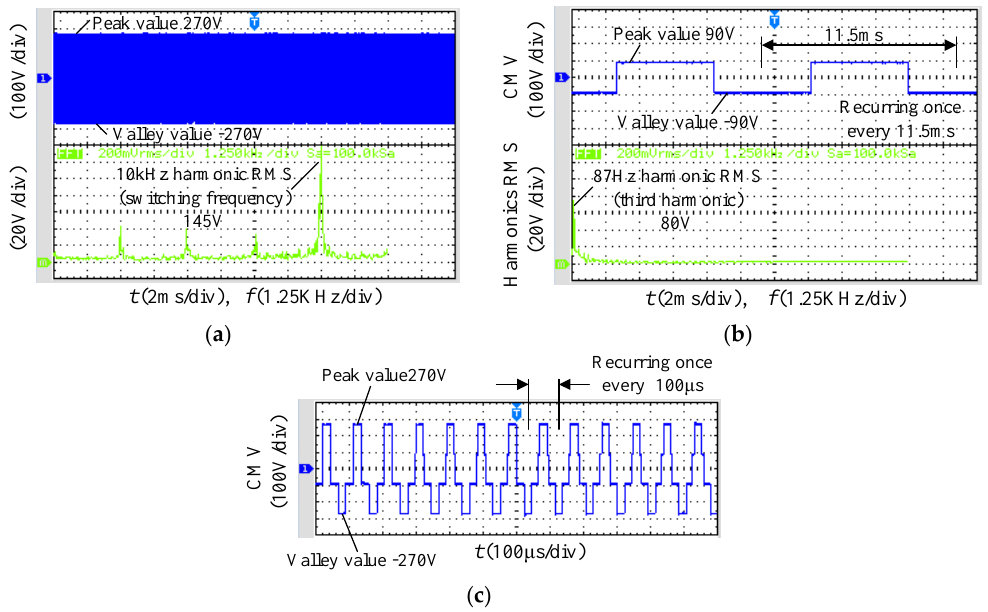
Figure 7. Common-mode voltage experimental waveforms and their FFT analysis in two methods. ( a ) Conventional SVPWM; ( b ) CMRSVPWM; ( c ) Conventional SVPWM (zoom).